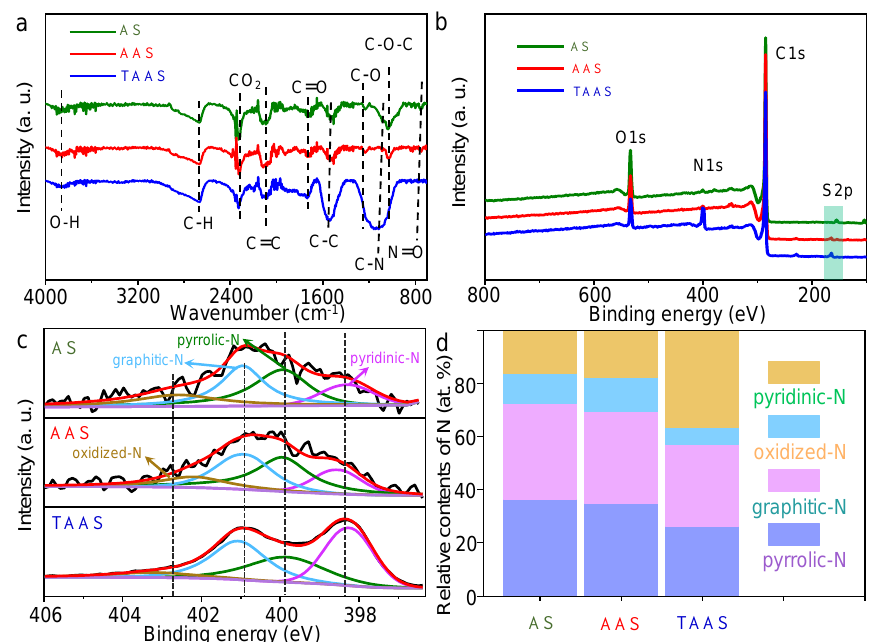
Figure 3. FT-IR diagram of AS, AAS and TAAS ( a ). XPS spectrum ( b ), high-resolution XPS spectrum of N 1s ( c ) and 3D bar graphs of the relative content of nitrogen species on the surface of AS, AAS and TAAS ( d ).